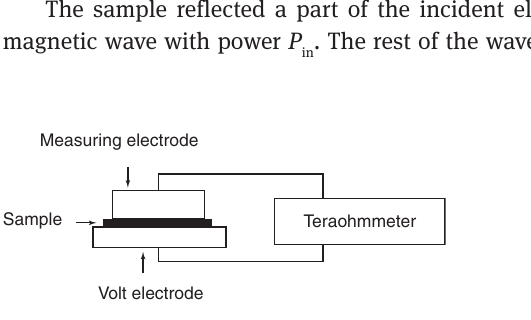
Figure 2: Scheme of the laboratory equipment for volume resistivity measurements.